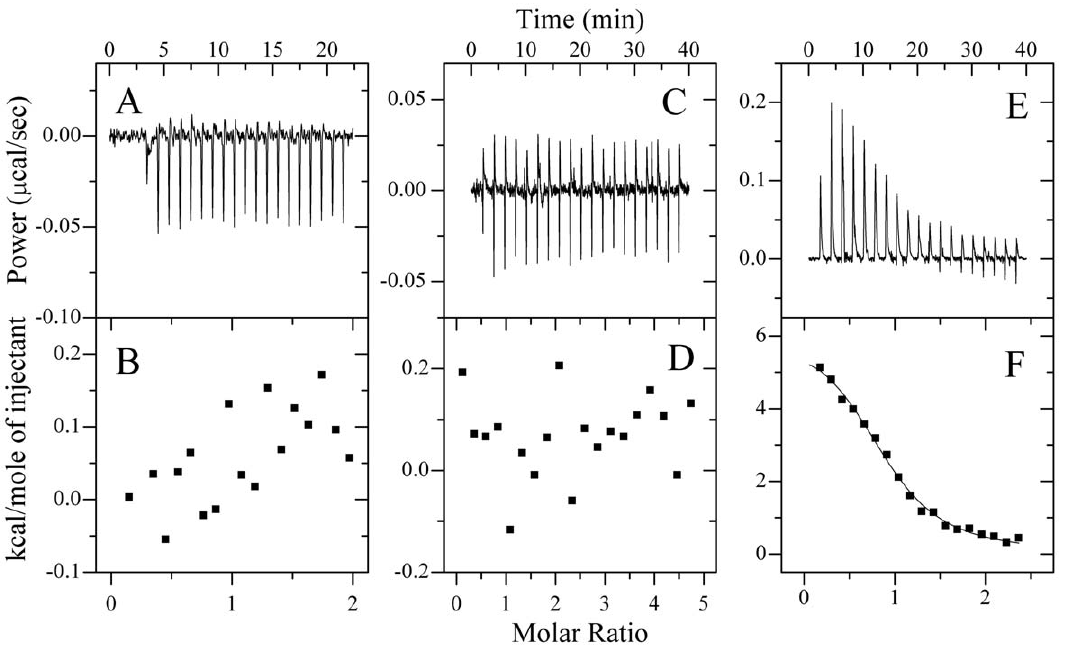
Figure 4. Interaction of H-Ras, K-RasB-(DESGPC), and H-Ras-(KKKKKK) with Ca 2 + /CaM at 25.0 6 C. The panels A, B, and C represent typical calorimetric titration of H-Ras-GppNHp (30.0 m M), K-RasB-(DESGPC)-GppNHp (25.0 m M) and H-Ras-(KKKKKK)-GppNHp (25.0 m M) with CaM (300 m M) respectively in the presence of 1 mM CaCl 2 . The panels D, E, and F show the plots of the heat evolved (kcal) per mole of CaM added, corrected for the heat of CaM, against the molar ratio of CaM to Ras proteins. The data (solid squares) were fitted to a single set of identical sites model and the solid line represented the best fit.